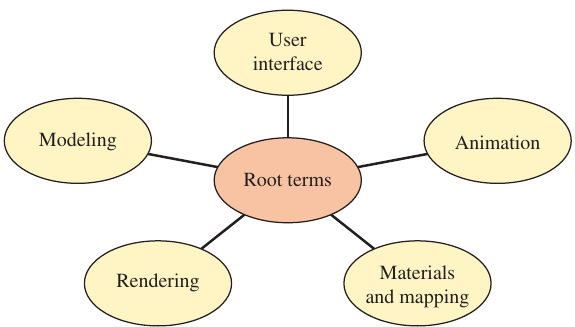
Figure 3. Root Terms – The Main